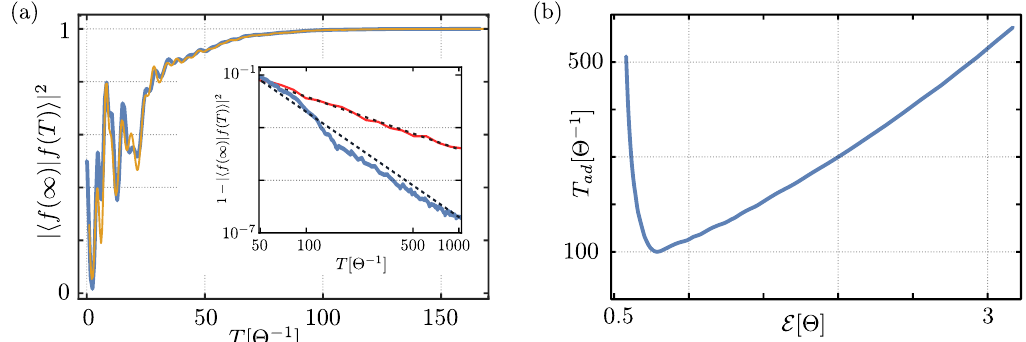
Figure 4: (a) Study of diabatic effects for a finite duration T of the "double tunneling" entangling scheme. The overlap |〈 f ( ∞ ) | f ( T ) 〉| 2 is plotted as a function of T (in units of Θ − 1 ). The blue line refers to the ideal protocol, i.e. Eq. (26), while the thin orange one considers the presence of finite parasitic coupling with V = Θ / 2 [ see Eqs. (28) and (29) ] . The inset display 1 − |〈 f ( ∞ ) | f ( T ) 〉| 2 on a logarithmic scale. The blue line refer to the same ideal protocol plotted in the main panel; the red one is obtained with a different choice of the interpolating function: ˜ g ( l ) = l instead of the g ( l ) in Eq. (8). The reference black dashed lines display the power laws T − 4 and = Θ = Θ and τ − τ = T / 6. (b) Adiabatic threshold T − 2 . Parameters: E = Θ x y j + 1 j = Θ = Θ time T (units Θ − 1 ) as a function of E (units Θ ) for fixed Θ ad y x